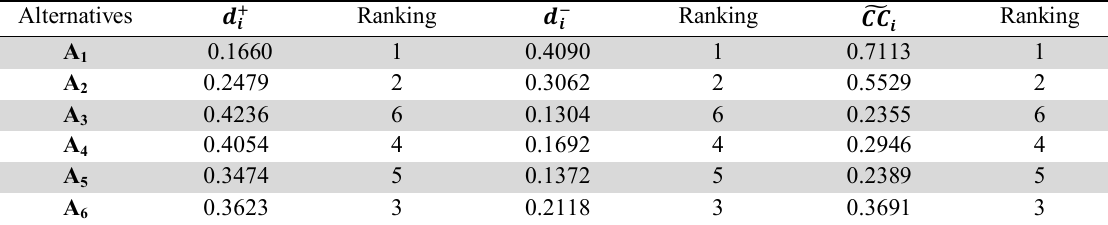
Final evaluation of the